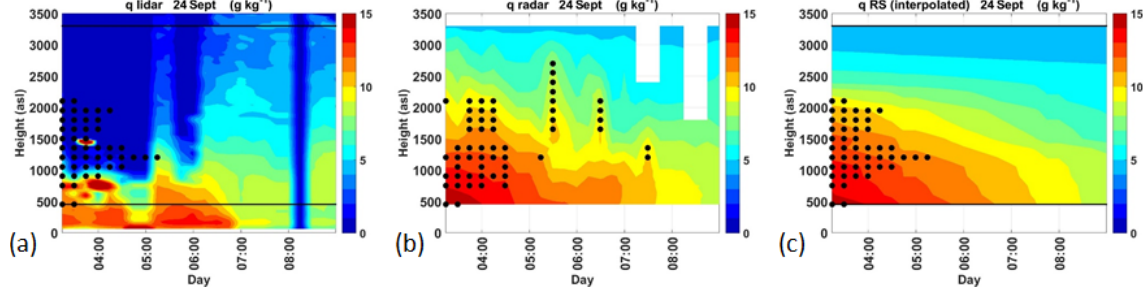
Figure 7. Time–height cross sections of q observed on 24 September 2012 by the lidar (a) , calculated from the radar data (b) and interpolated between RS1 and RS2 (c) . The dots are for the radar saturated values in panel (b) and RS saturated values in panels (a) and (c) .